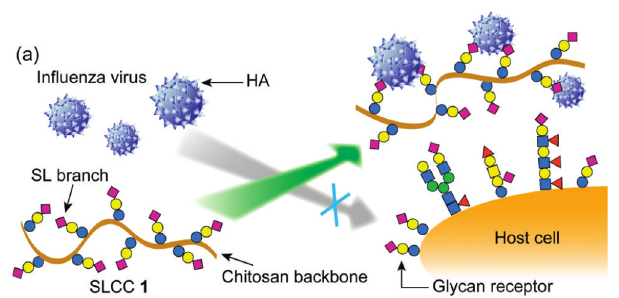
Figure 7. Sialyllactose-chitosan derivative as potential virus adsorbent for prevention and control of influenza. Adapted with permission from Biomacromolecules 2011, 12, 11, 3962-3969. Copyright (2011) American Chemical Society.